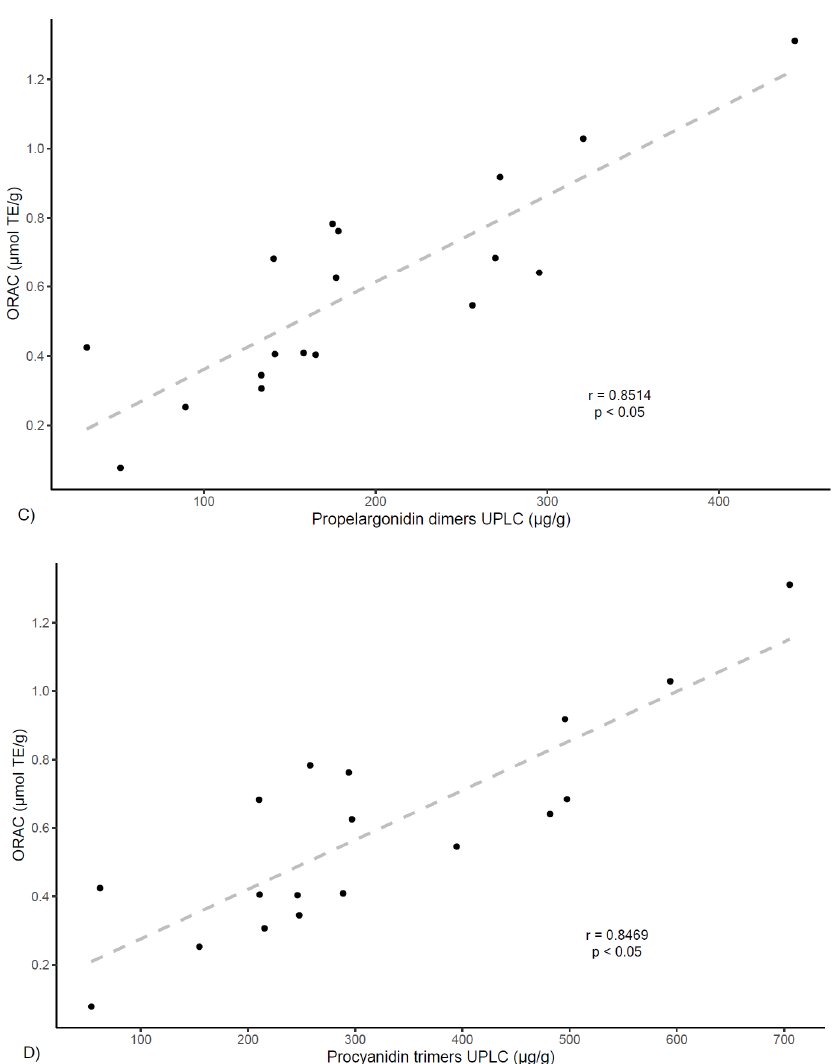
Figure 5. Correlation of antioxidant scavenging activity assessed by the ORAC method with UPLC quantification of flavan-3-ols subgroups: ( A ) monomers; ( B ) procyanidin dimers; ( C ) propelargonidin dimers; and ( D ) procyanidin trimers.